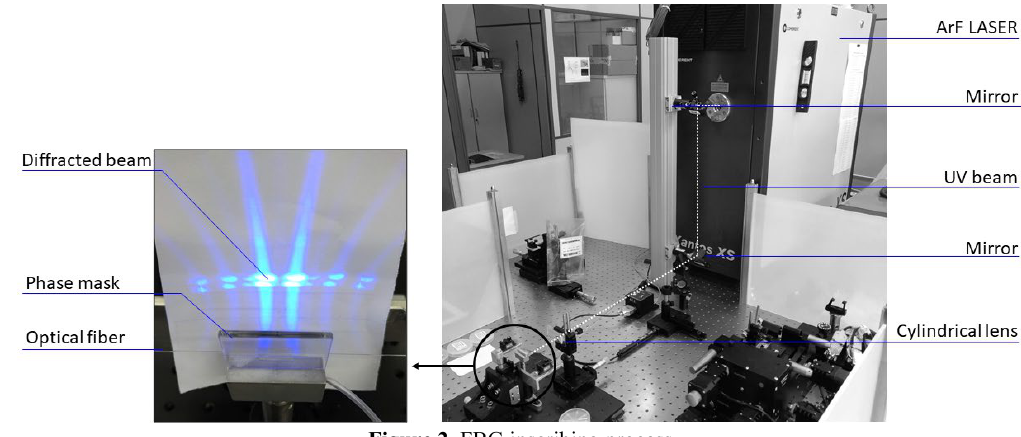
Figure 2. FBG inscribing